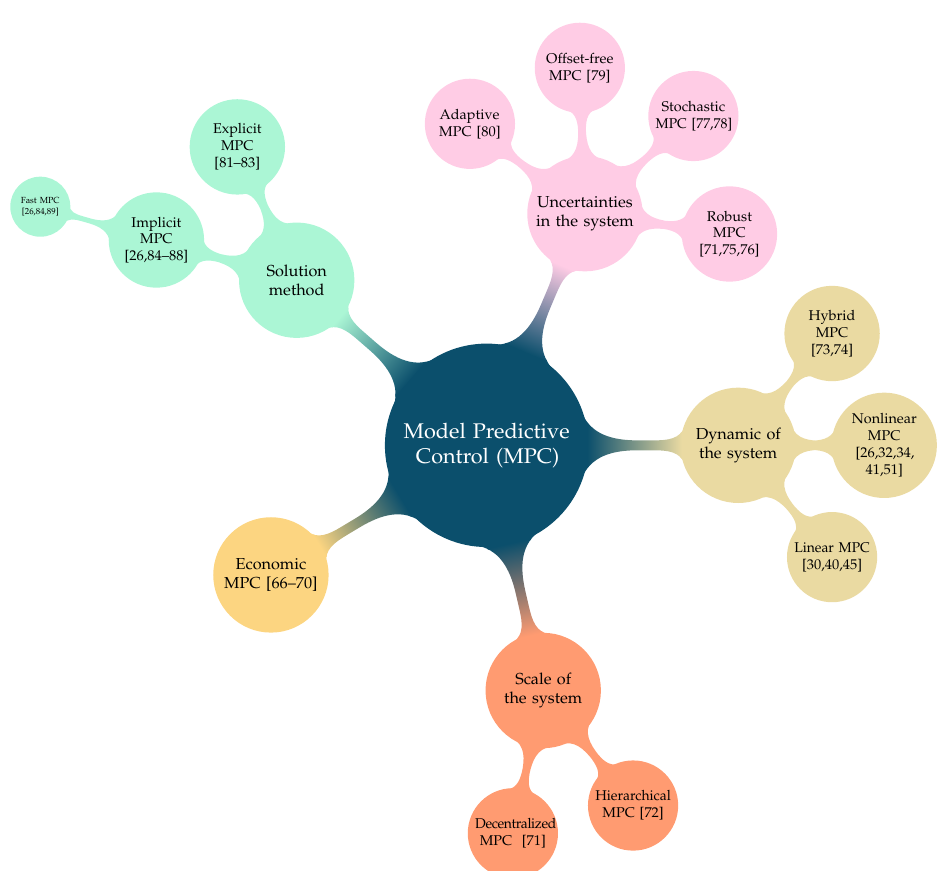
Figure 3. MPC categories and corresponding MPC methods